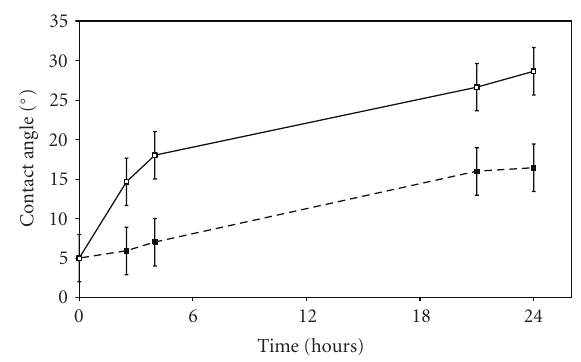
Figure 3: Variation in CA versus time for initially pristine superhydrophilic sample of Activ ( (cid:2) ) and glass ( (cid:3) ) under ambient laboratory conditions.